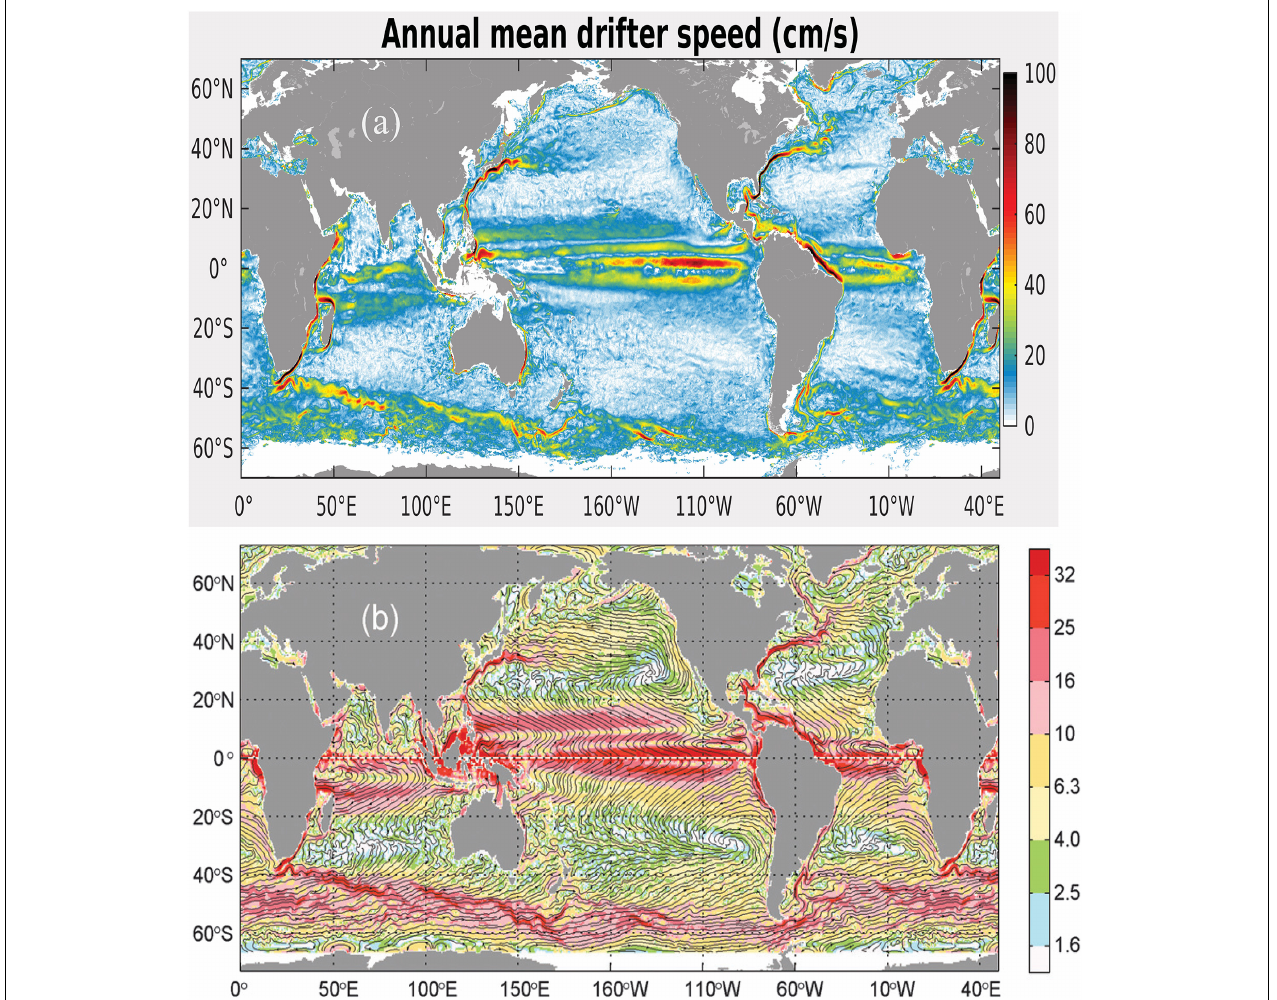
FIGURE 2 | (a) Time mean near-surface current speed (cm/s) measured by GDP drifters; climatology available at https://www.aoml.noaa.gov/phod/gdp/mean _velocity.php. (b) Mean streamlines calculated from a combination of mean geostrophic and Ekman velocities; colors are magnitudes of mean geostrophic plus Ekman velocity (cm/s) used to compute the streamlines (from Maximenko et al., 2009).